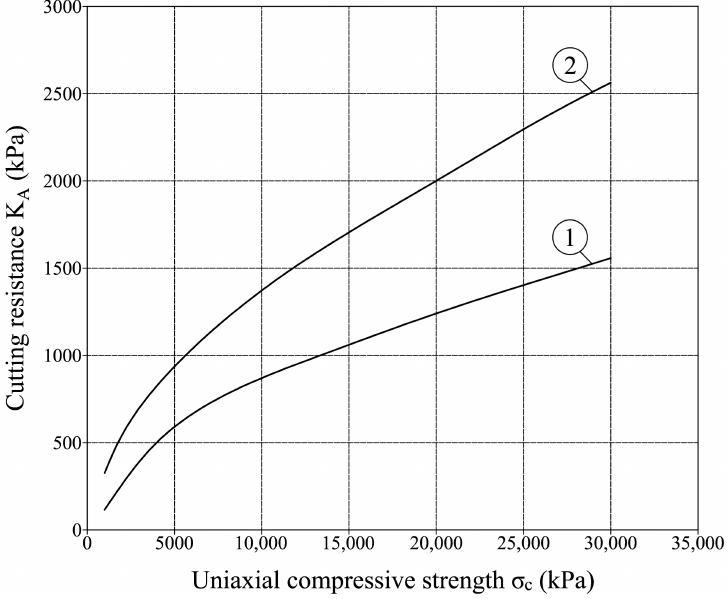
Figure 6. Relationship between cutting resistance, K A , and uniaxial compressive strength, σ c , (1—lowest value of K A , 2—highest value of K A ).